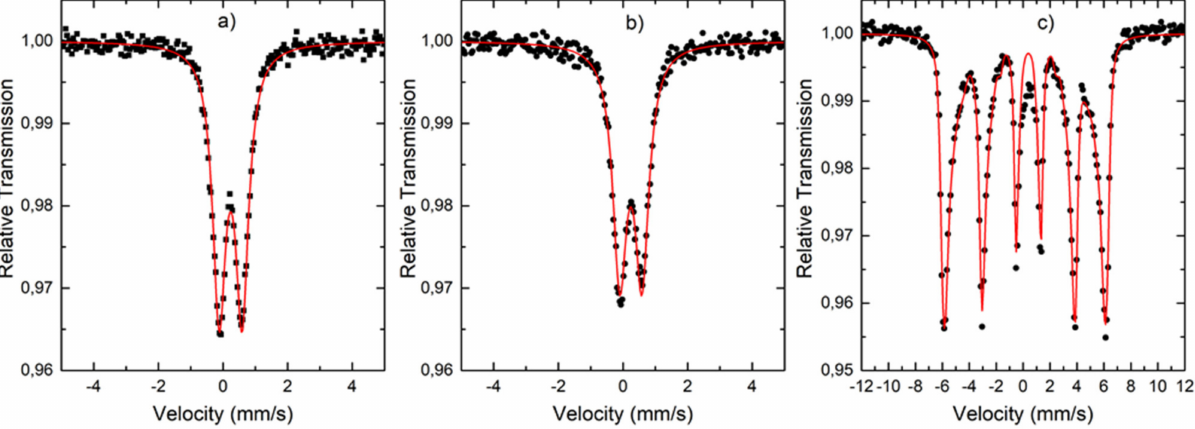
Figure 4. Mössbauer spectra of ferrihydrite ( a ) FMBO ( b ) goethite, and ( c ) samples taken at room temperature. Solid red lines are the best fits and black dots indicate the experimental